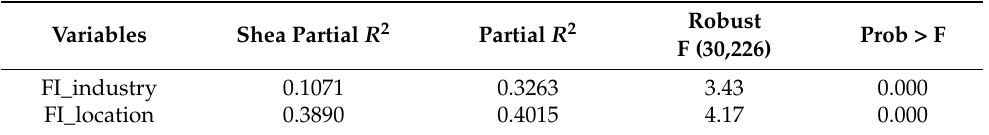
Table 6. First-stage regression summary